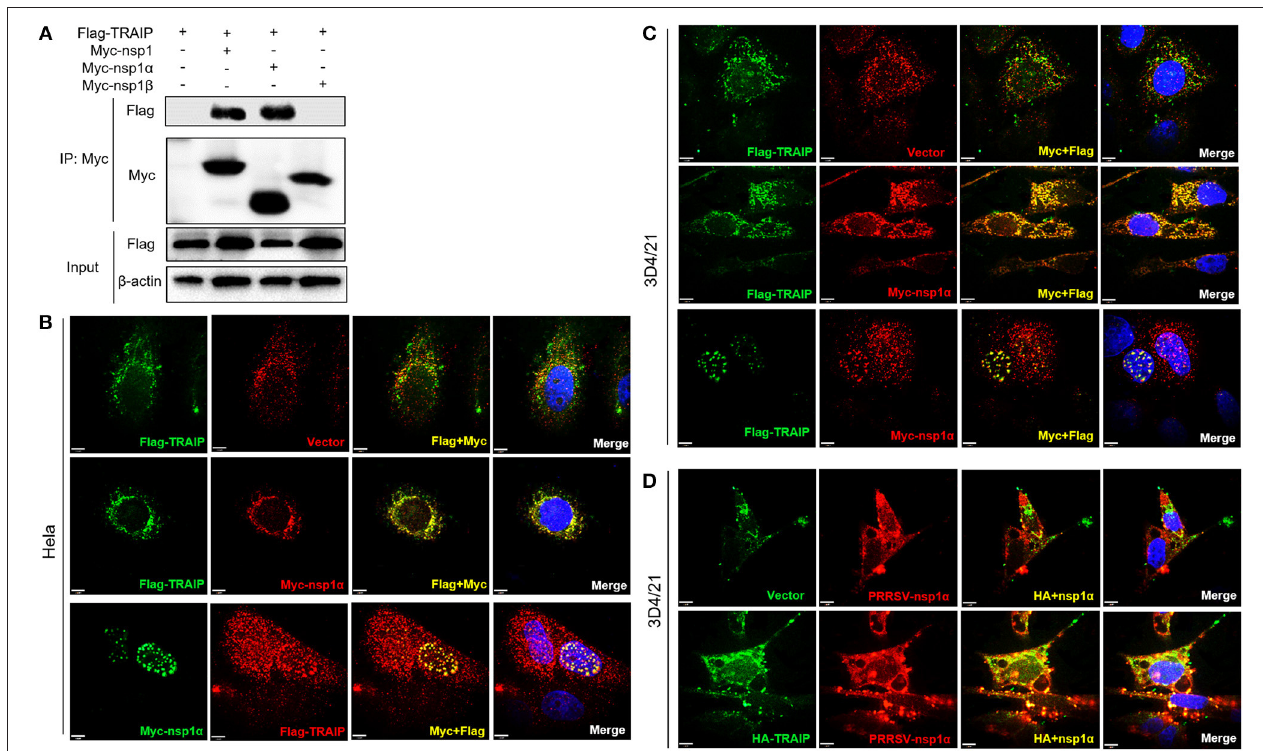
FIGURE 3 | TRAIP interacts with PRRSV-nsp1 α . (A) HEK293 cells were first transfected with Flag-TRAIP and then co-transfected with Myc-nsp1, Myc-nsp1 α , Myc-nsp1 β , vector expressing plasmids. The cell lysates were then immunoprecipitated with an anti-Myc MAb and detected by Western blotting at 24h post-transfection. (B,C) Co-localization of nsp1 α protein with TRAIP in the cytoplasm and nucleus in HeLa cells and 3D4/21 cells. HeLa or 3D4/21 cells were seeded in 12-well plates and co-transfected with Flag-TRAIP and Myc-nsp1 α expressing plasmid. At 18h post-transfection, the cells were incubated with a rabbit anti-Myc mAb and a mouse anti-Flag antibody followed by FITC-conjugated anti-mouse IgG (green) and PE-conjugated anti-rabbit IgG (red) or FITC-conjugated anti-rabbit IgG (green) and PE-conjugated anti-mouse IgG (red). (D) Porcine TRAIP co-localize with PRRSV-nsp1 α in PRRSV infection of 3D4/21 cells. Nuclei were stained with DAPI (blue). Cells were observed under a laser confocal imaging analysis system, scale bar: 7 µ m.